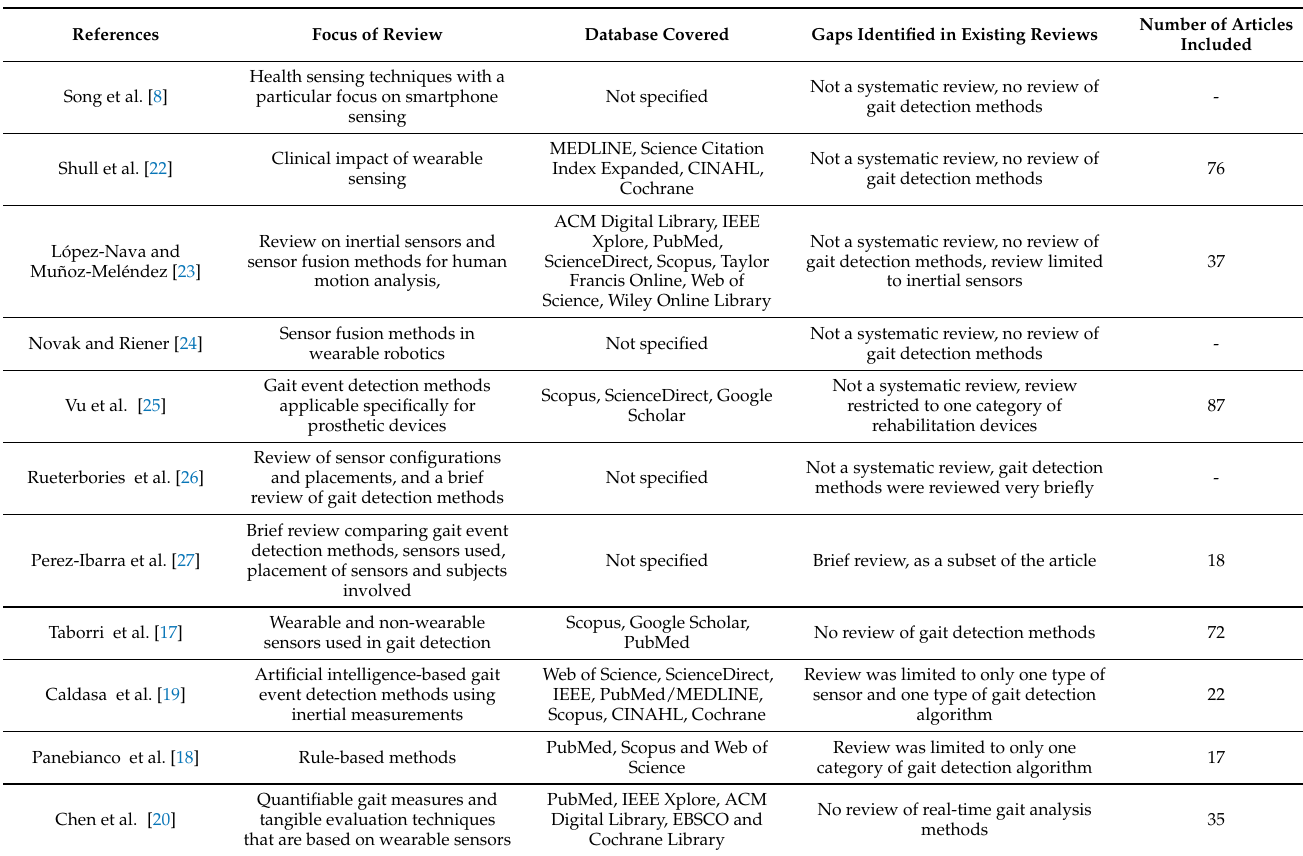
Table 1. Previous reviews: gaps identified from existing review articles from literature, covering wearable sensor-based gait